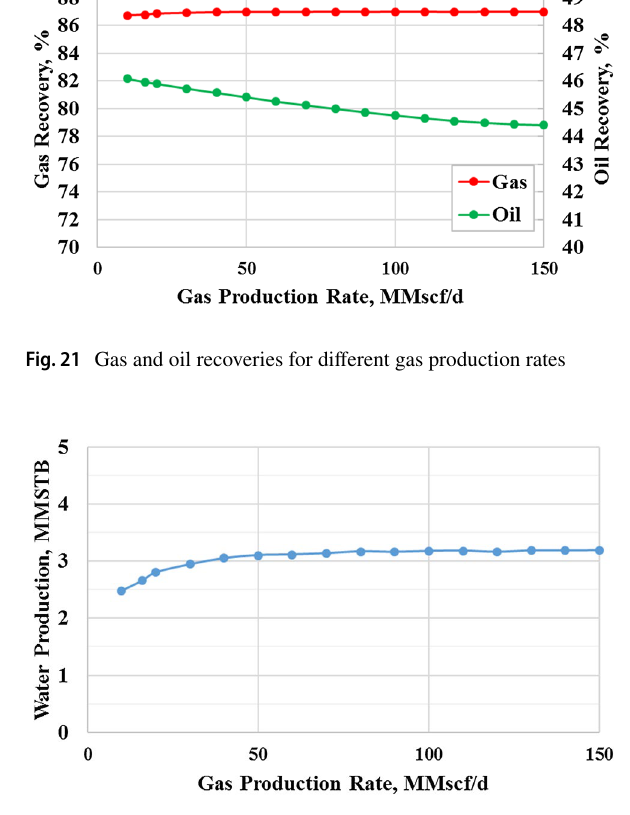
Fig. 22 Total water production for different gas production